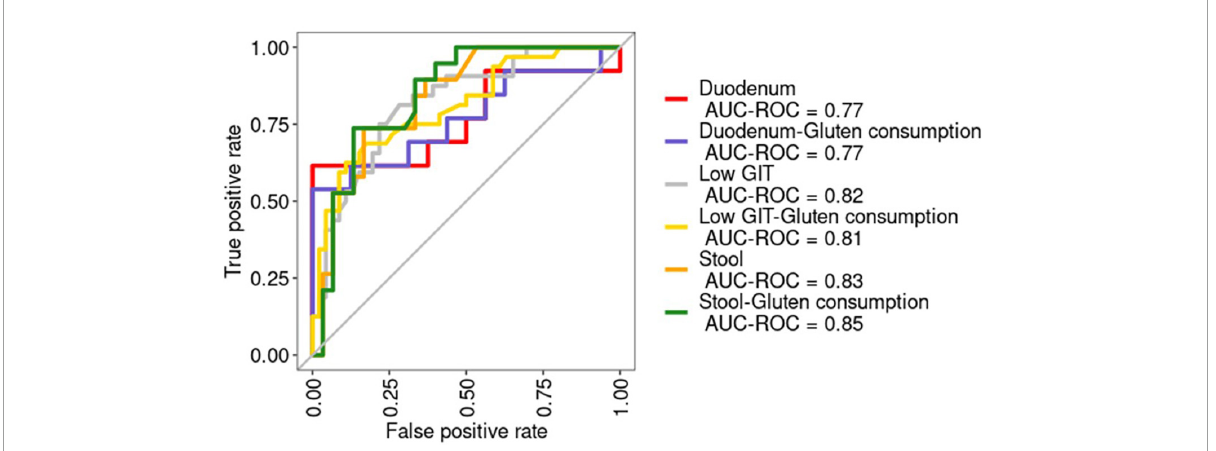
FIGURE8 Receiver operating characteristic (ROC) curves for the six models built. The area under the ROC curve (AUC) is shown. AUC-ROC, Area under the ROC curve. Duodenum: RF model using duodenum samples. Duodenum-Gluten consumption: RF model using duodenum samples including information about gluten consumption. Low GIT: RF model using pooled samples from the lower gastrointestinal tract (stool and duodenum). Low GIT—gluten consumption: RF model using pooled samples from the lower gastrointestinal tract (stool and duodenum) including information about gluten consumption. Stool: RF model using stool samples. Stool—gluten consumption: RF model using stool samples including information about gluten consumption.